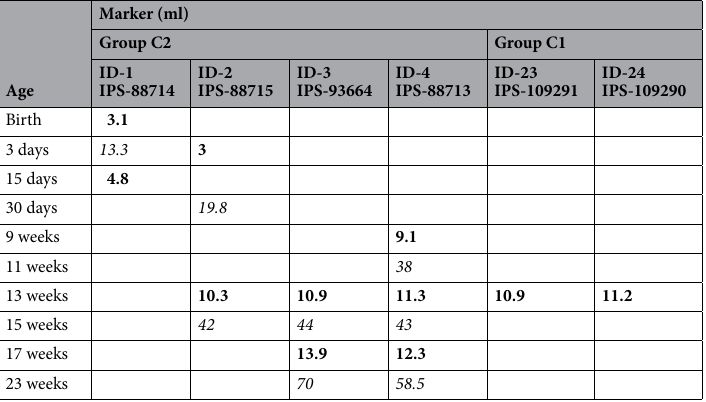
Table 2. Schedule of alternated calcein green (bold) and alizarin complexone labelling (italic) and the amounts of fluorochrome marker administered (Alizarin complexone 30 mg/kg; calcein green 8